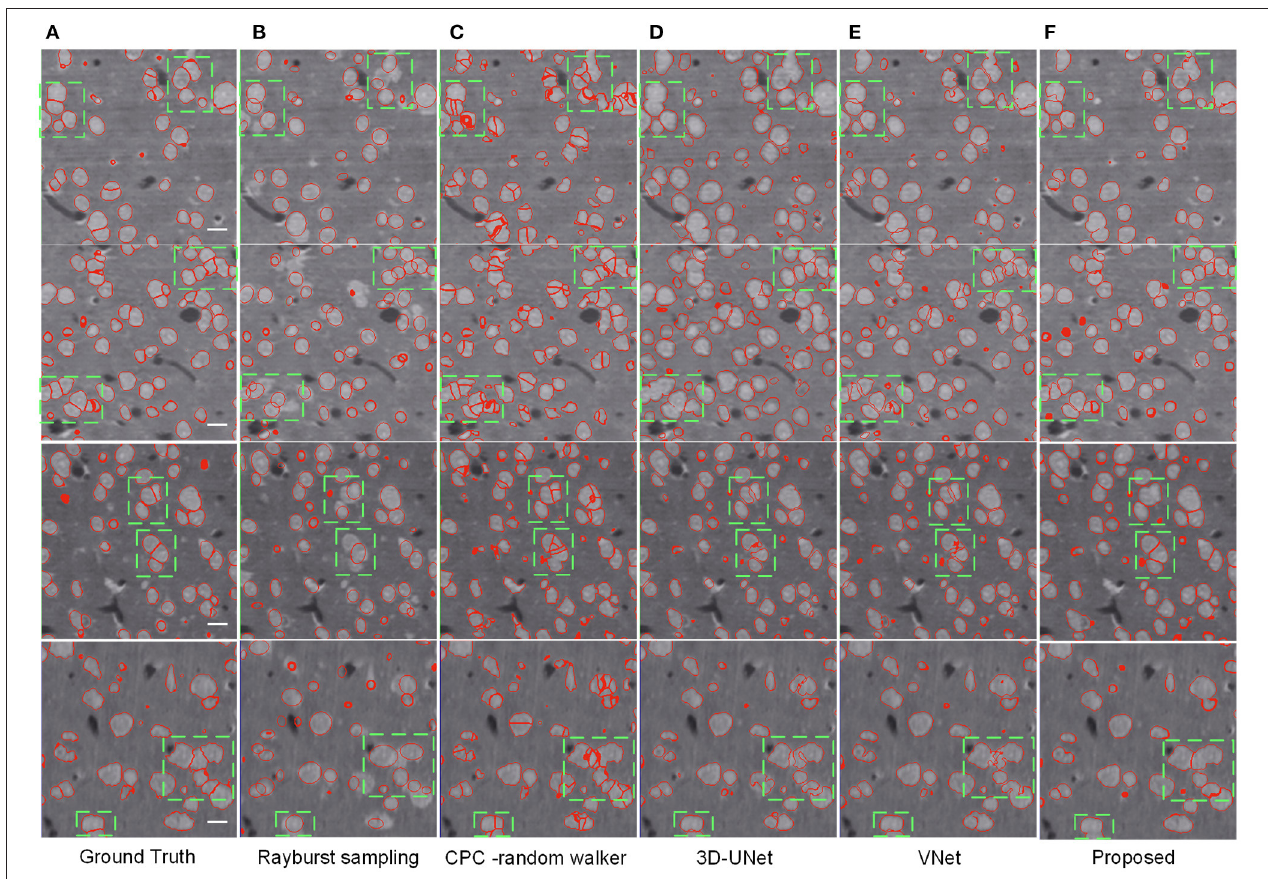
FIGURE 7 | Segmentation results of different methods. (A) Ground truth; boundary of random color label is used to represents segmentation result, the slices are extracted from three different volumes. The horizontal bar indicates a distance of 10 µ m. (B) Distance transform based rayburst algorithm. (C) CPC random walker. (D,E) 3D UNet and VNet with spatial weighted cross-entropy loss, respectively. (F) Proposed method. Several typical regions, including touching neuronal somata are extracted by green bounding boxes for comparing the methods.